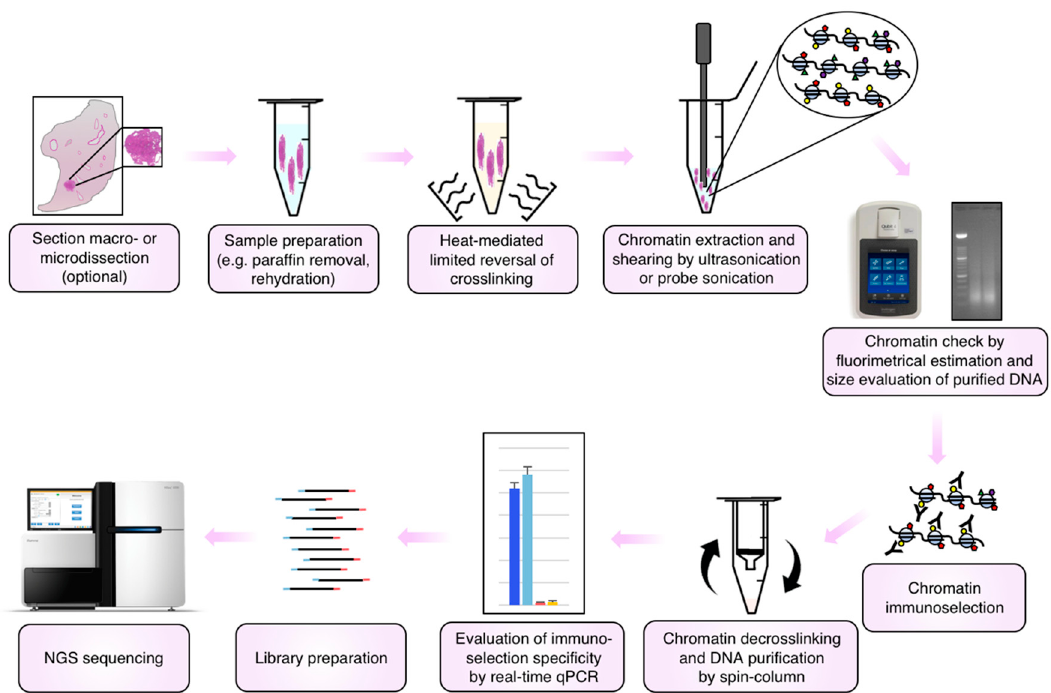
Figure 2. Schematic overview of the main steps shared by the different procedures described in this review. FFPE tissue sections can be collected from the block as a whole or dissected (macro- or micro-) to enrich the starting material of specific tissue components. The sections are deparaffinized and rehydrated prior to be subjected to limited reversal of crosslinking by heat and chromatin extraction and shearing by focused ultrasonication or canonical probe sonication. Then, chromatin should be checked prior to proceed with immunoselection: an aliquot of chromatin is taken and decrosslinked, and the DNA is purified, fluorimetrically quantified, and separated by electrophoresis to evaluate the size of fragments. Chromatin is then immunoselected using antibodies directed against the protein or histone modification of interest. After capture of chromatin–antibody complexes and their washing to remove the nonspecific chromatin binding, selected chromatin is decrosslinked and purified using spin-column strategies. Finally, a preliminary evaluation of the specificity of the immunoselection by real-time qPCR should be performed prior to library preparation and NGS sequencing.